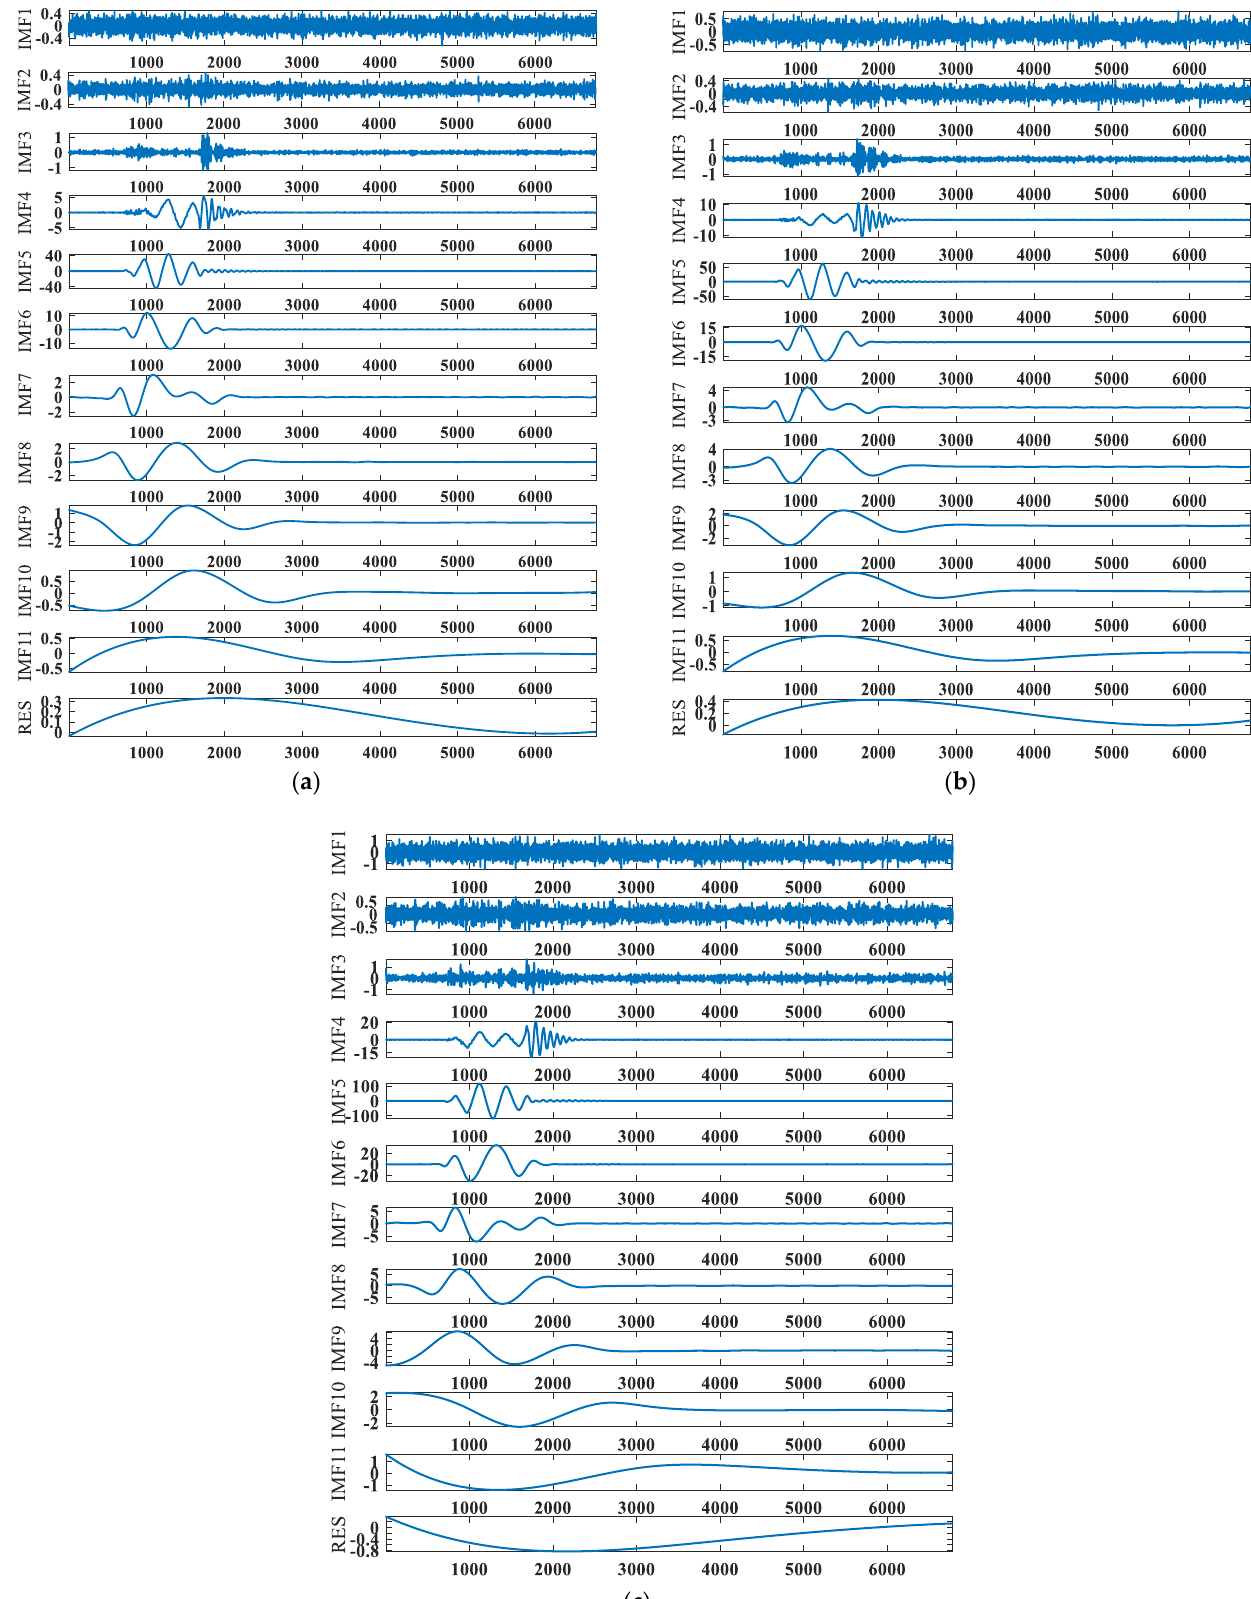
( b ) Figure 5. ( a ) Three-phase current of the faulty line. ( b ) Zero sequence current of three lines. EEMD decomposes the zero sequences current waveform. The EEMD results show that the frequency domain signal direction of the fault line is different from the direction of the first two lines, and the current amplitude of the ground fault line is larger. The fault line can be found by comparing the difference between the normal line and the